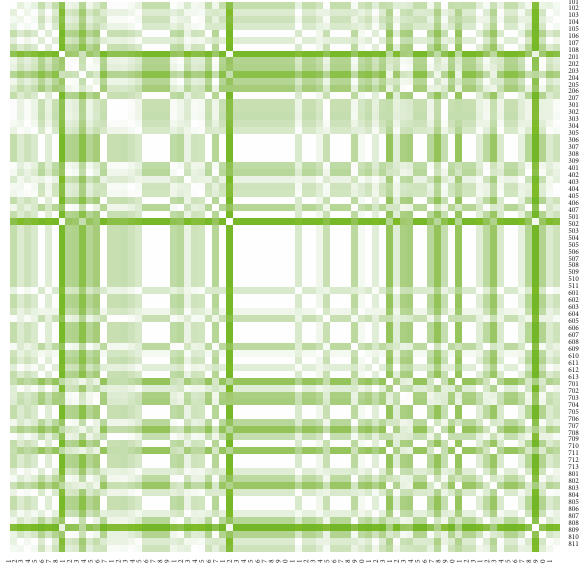
Figure 18: The distance matrix of the similarity of the districts for the male sex in